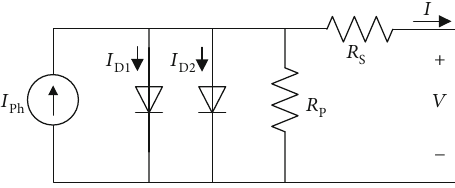
Figure 1: The two-diode model of solar cells.